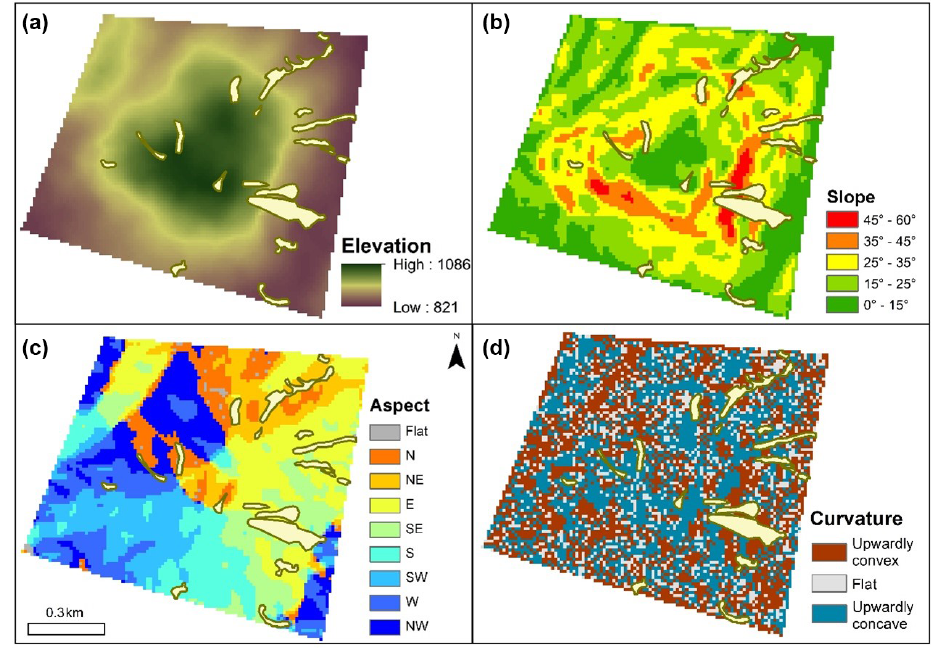
Figure 6. Distribution map of terrain attributes in the study area of Petrópolis. (a) Elevation, (b) slope, (c) aspect, and (d) curvature of Petrópolis. Light-yellow polygons represent the extent of the February 2022 landslide patches.